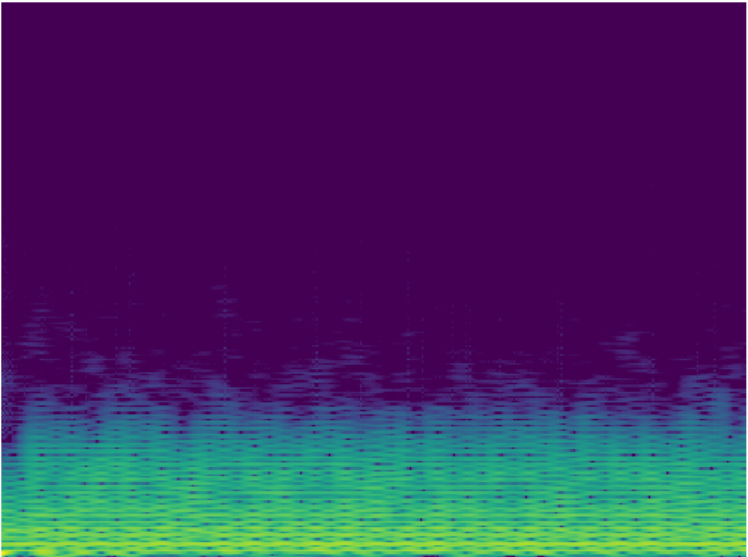
Figure 11. Spectrum of ECG signal with atrial